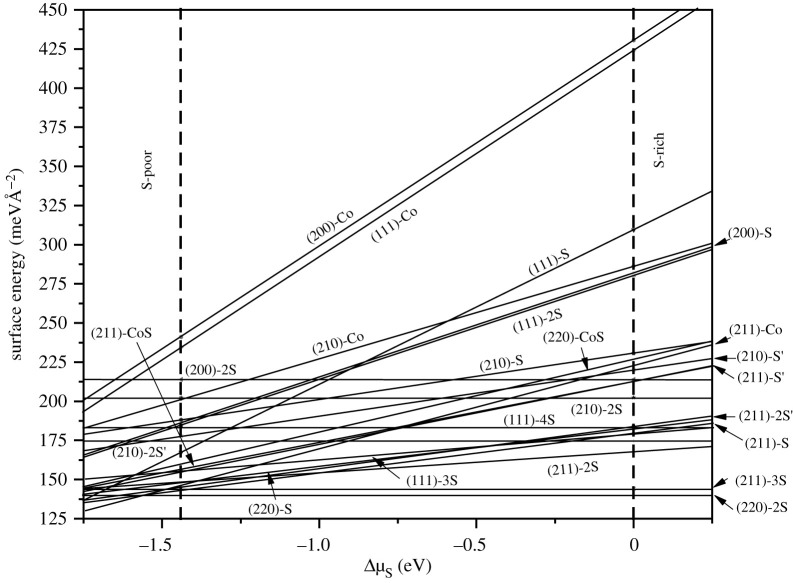
Calculated surface free energies of various CoS2 surfaces as functions of S chemical potential.